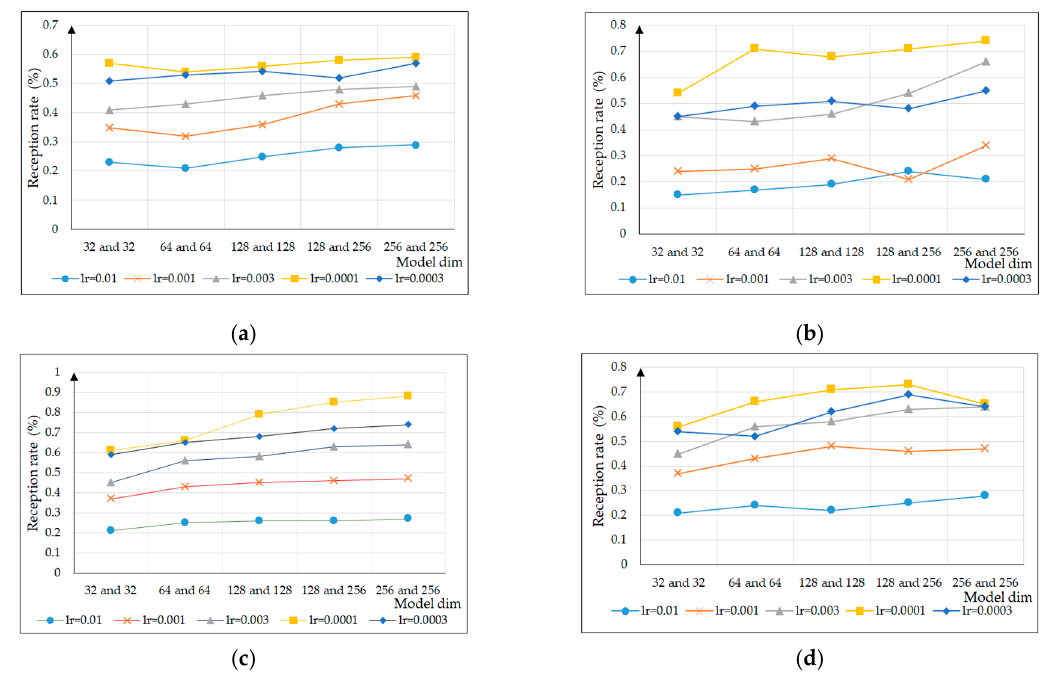
τ values: ( a ) 0.4 τ= Figure 9. Comparison of super parameter selection in the model under di ff erent τ values: ( a ) τ = 0.4;